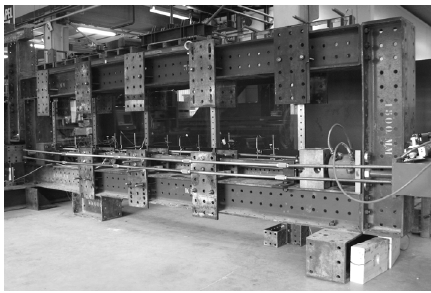
Figure 7: Specimen with temporary supports during curing of the epoxy adhesive.